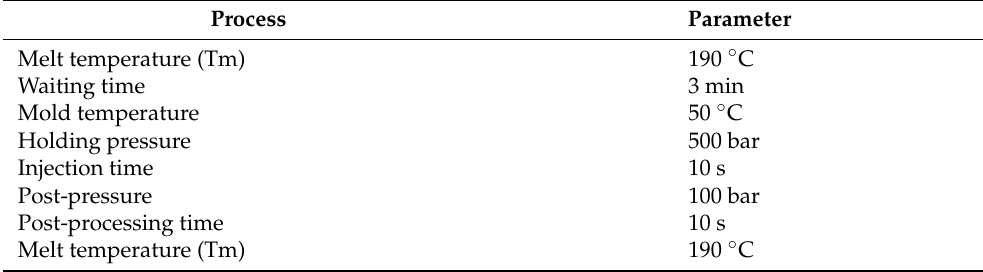
Table 2. Process parameters for injection-molding of test bars for DMA. Process